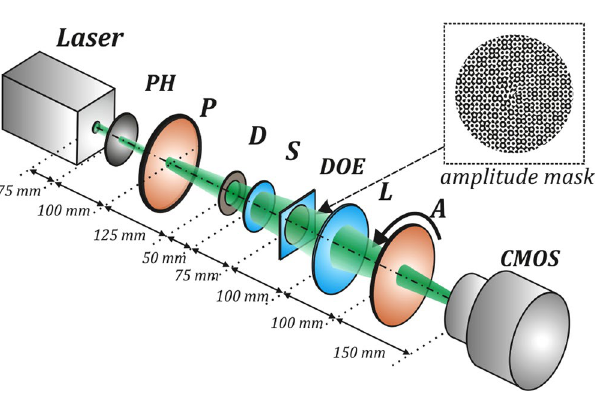
Figure 3. Distribution of the azimuthal and radial components of the electric field. ( a ) in the absence and ( b – f ) in the presence of a vortex phase: ( b ) m = ± 1, ( c ) m = ± 2, ( d ) m = ± 3, ( e ) m = ± 4, ( f ) m = ± 10. The radial component is denoted by brown lines and the azimuthal component is denoted by green lines.